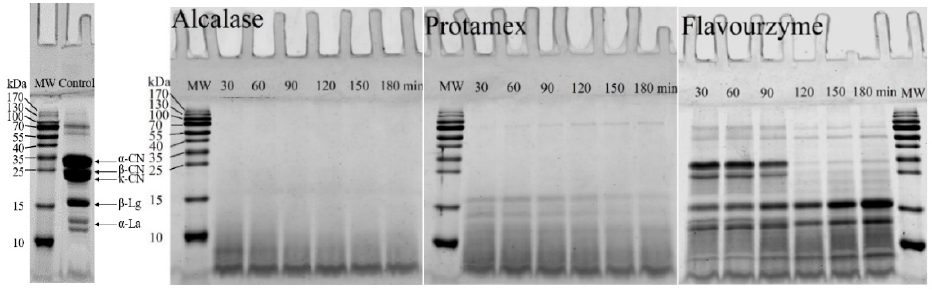
Figure 1. Sodium dodecyl sulfate–polyacrylamide gel electrophoresis (SDS-PAGE) of MPC and samples hydrolyzed by Alcalase, Flavorzyme, and Protamex at 30, 60, 90, 120, 150, and 180 min, respectively. The molecular weight of standard markers employed were 170, 130, 100, 70, 55, 40, 35, 25, 15, and 10 kDa, respectively.